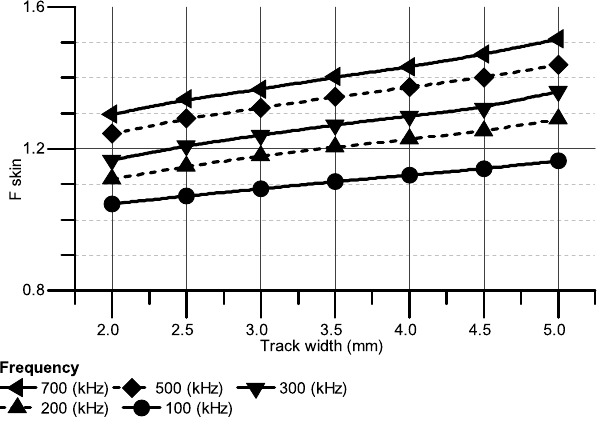
Figure 4. F skin of 2 Oz copper track with various track width simulated by Ansys